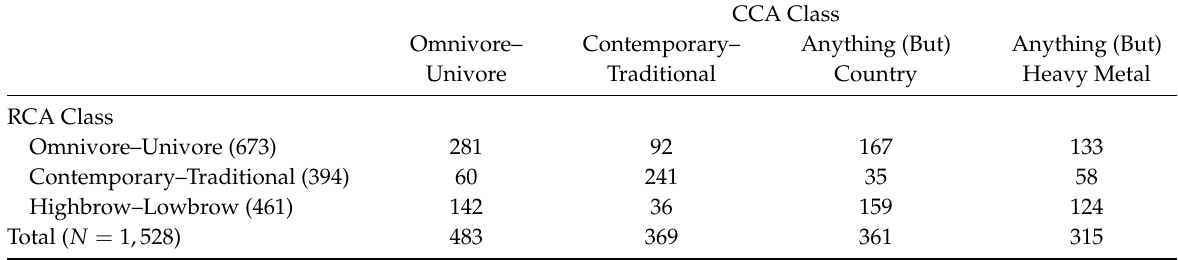
Table 3: Cross-tabulation of estimated schematic class memberships in 1993 GSS musical tastes